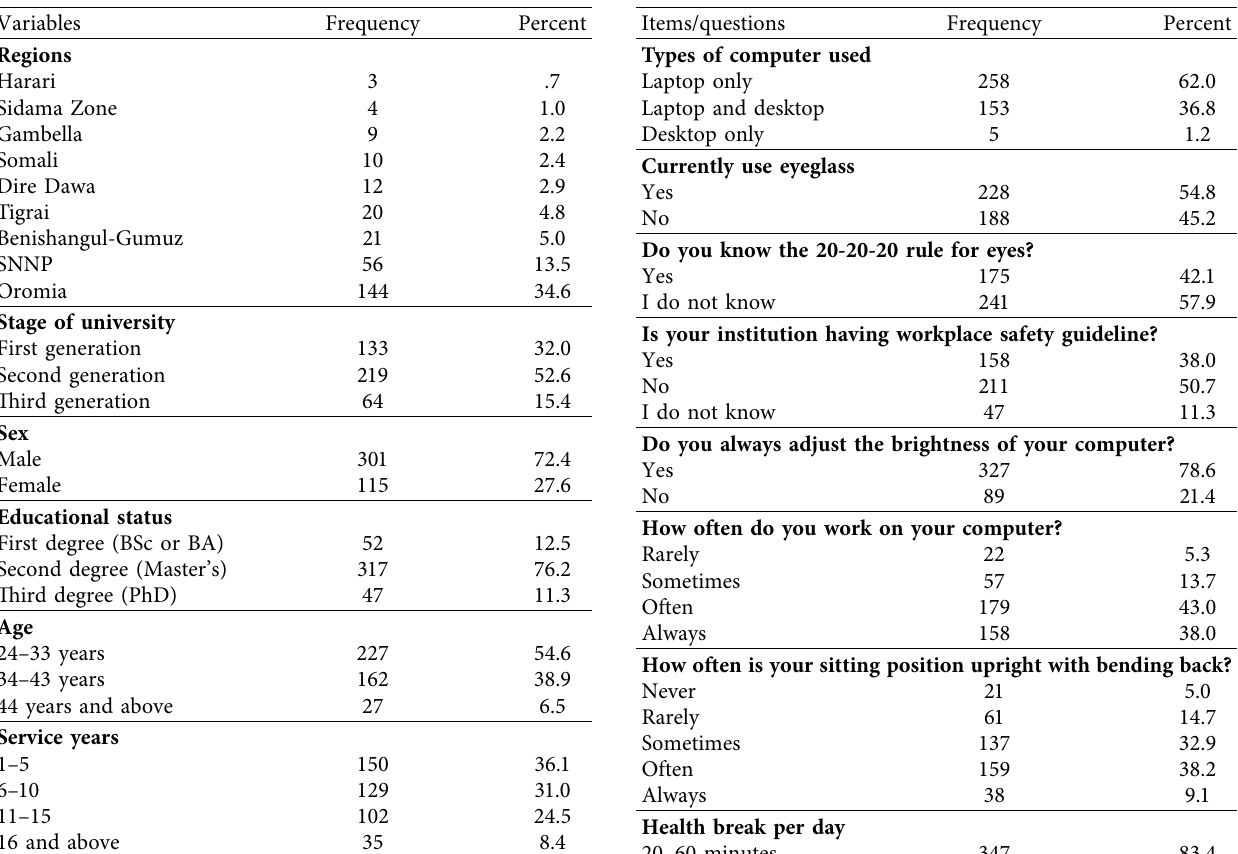
Table 2: Ergonomic practices and awareness during computer use among instructors in Ethiopian universities, 2021 ( n �